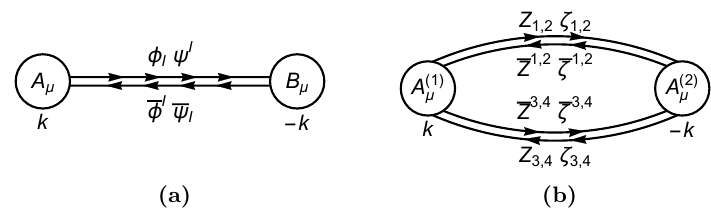
Figure 9. The quiver diagram of ABJ(M) theory in (a) ABJM notations and (b) N = 2 notations. In Minkowski spacetime, the bosonic 1/6 BPS WL along the line x (cid:22) = ( (cid:28); 0 ; 0)